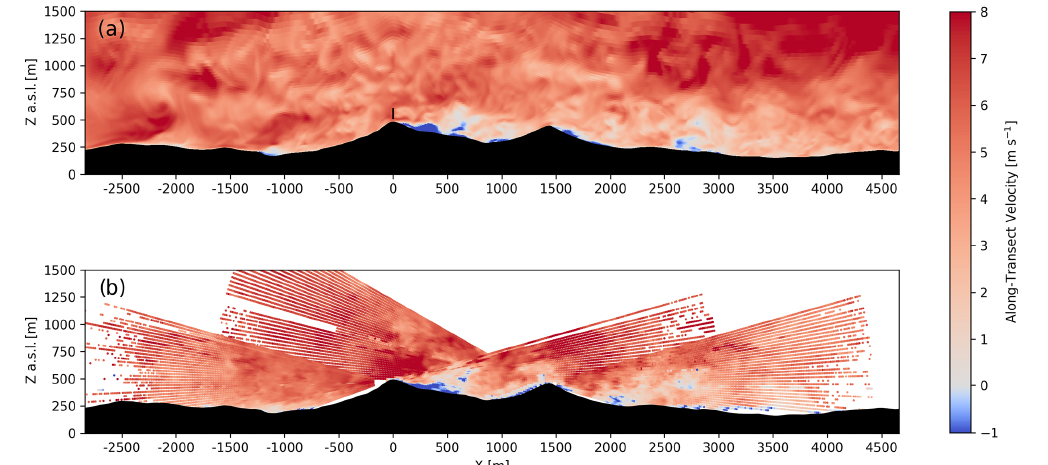
Figure 8. Instantaneous along-transect horizontal velocity during the convective case study for the model (a) and DTU multi-Doppler lidar scan (b) at approximately 13:20UTC. The output from the model is instantaneous while the multi-Doppler measurements are over the course of a single scan, which takes about 24s. The model transect is aligned with the wake transect and the lidar transect is aligned with the offset transect in Fig. 1. An animation of model results during the entire 1h period is included in the supplementary material (see Video 3 in the Video supplement).